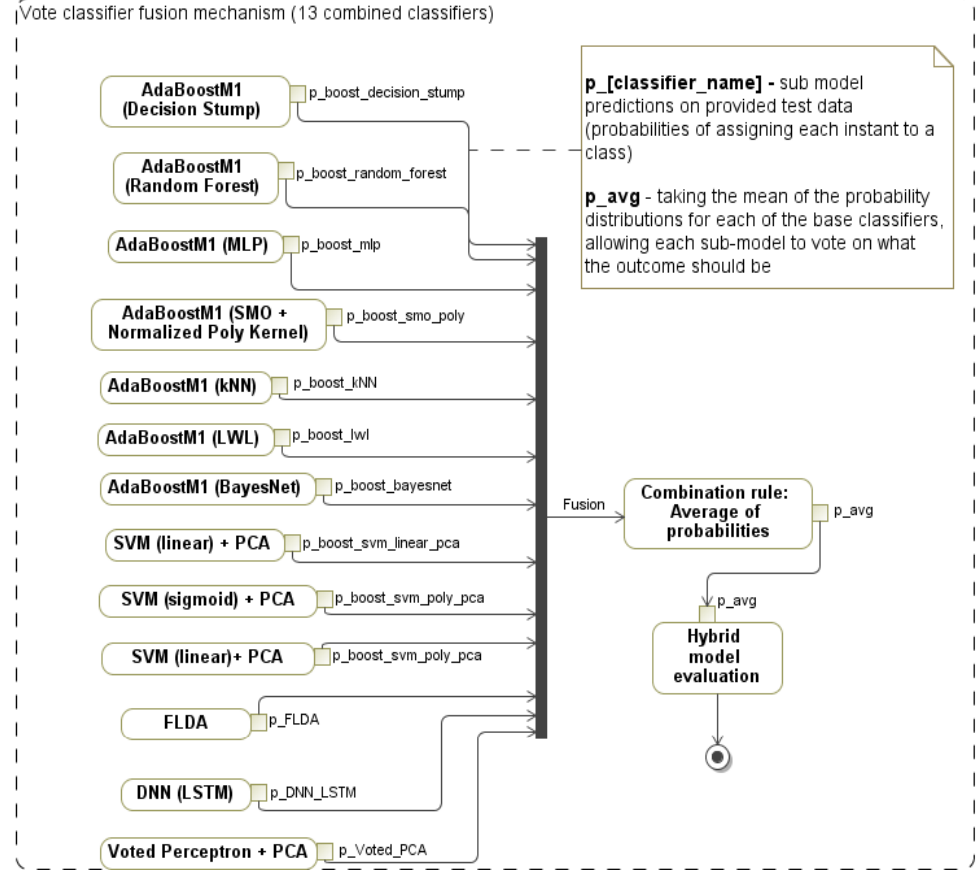
Figure 4. Proposed hybrid classification model that combines 13 classifiers for the detection of tremor, cognitive, and energy expenditure